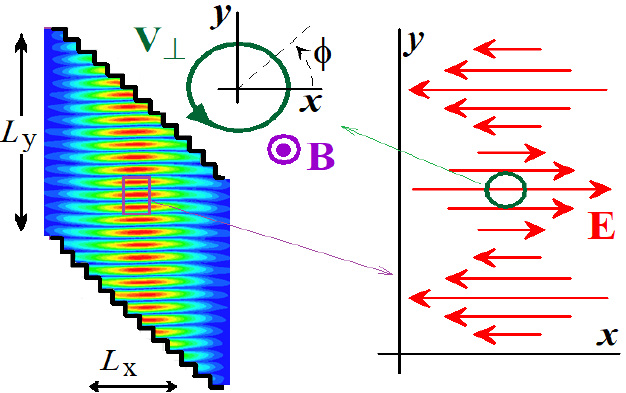
Figure 9. Illustration of the mechanism of the electron – wave interaction.